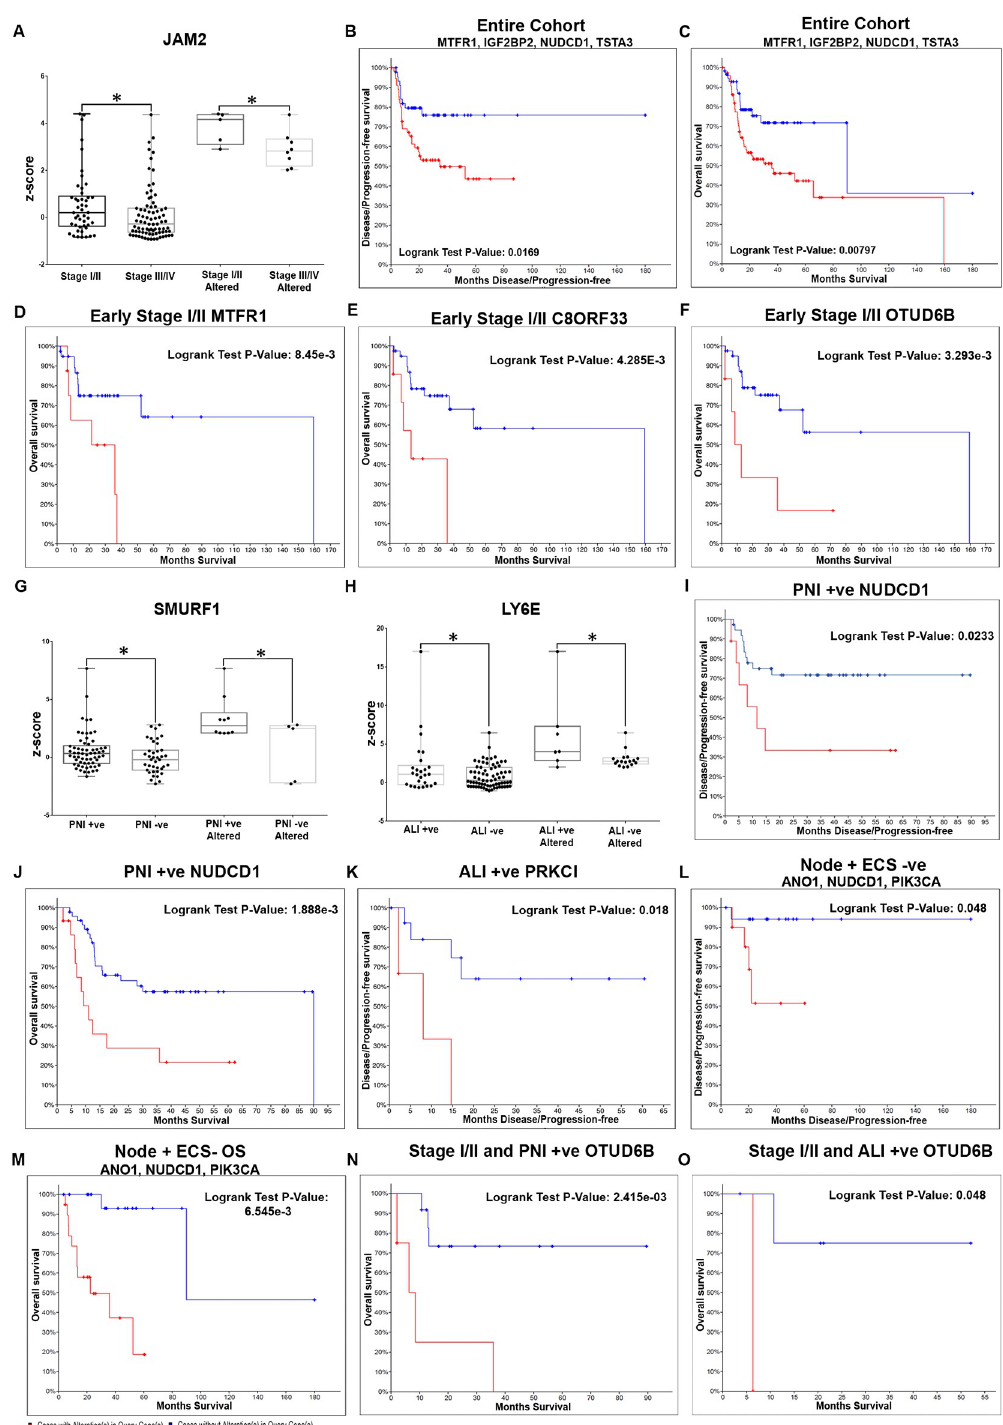
Fig 3. Molecular markers with significant differential expression and prognostic efficacy in tongue cancer. Significant differentials from tongue cancer meta-analysis were validated in terms of mRNA expression levels (z-score) across stage/ pathological parameters in the TCGA tongue cancer cohort. In early stage tongue cancers, JAM2 showed a significantly upregulation ( ± 2 fold) as compared to late stage (A) , with no effect on survival. Assessment of prognostic efficacy (genes > 20% alterations) indicated that in the entire cohort ( B and C ), a combination of MTFR1, IGF2BP2, NUDCD1 and TSTA3 clearly showed a poor DFS (p = 0.0169) and OS (p = 0.00794). In early stage cancer (D-F) , MTRF1 (p = 8.450e-3),